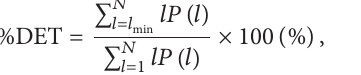
because we do not require 𝑟 (𝑖) = 𝑟 (𝑗) [27]. When 𝑁 is more than 2 dimensions in a phase space, projection is